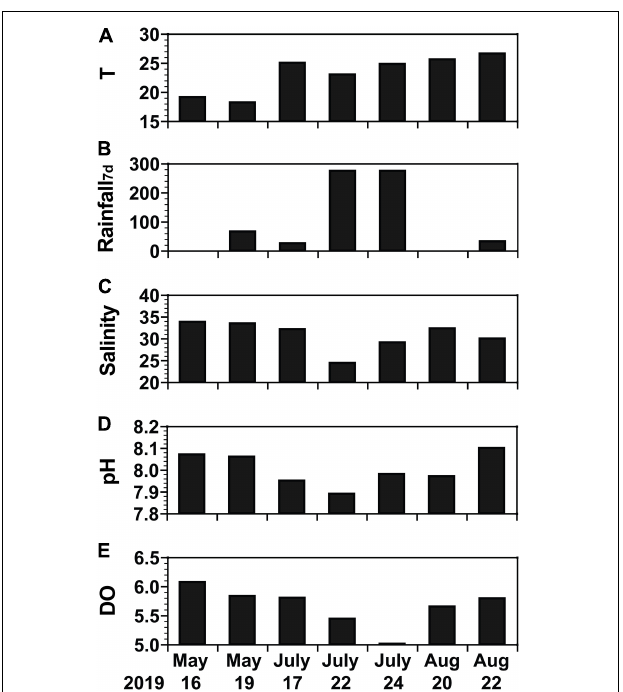
FIGURE 2 | Background environmental conditions of water samples from May 16 to August 22, 2019. (A) Temperature (T, ◦ C), (B) amount of rainfall for